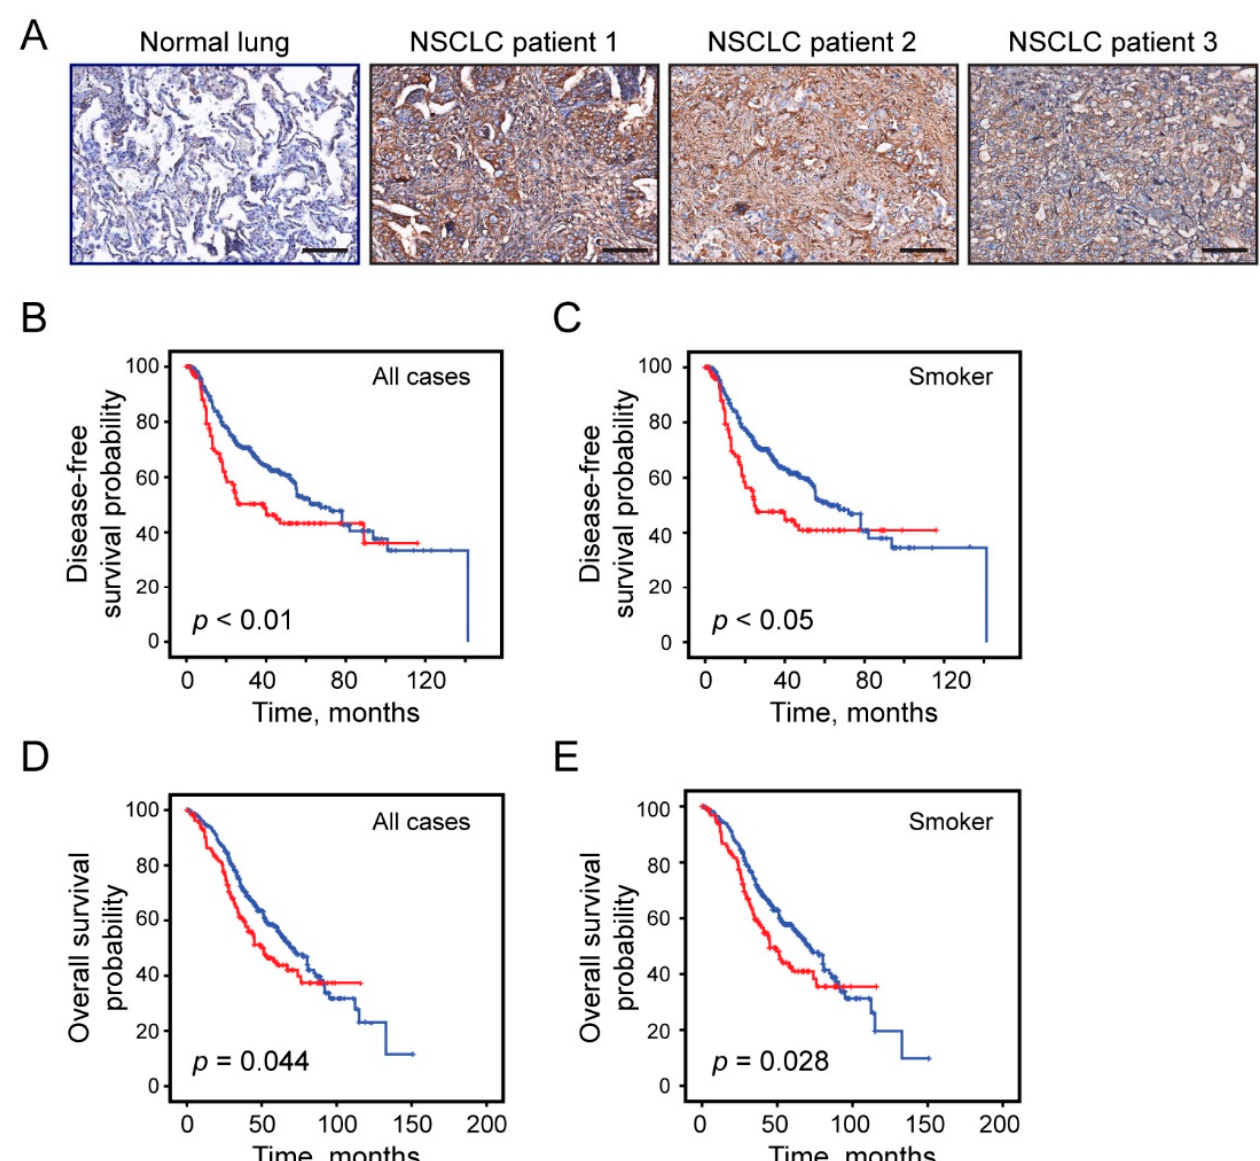
Figure 1. Oncofetal CS expression in NSCLC and survival analyses: ( A ) representative images of oncofetal CS expression in normal human lung and NSCLC tissue samples. The scale bar represents 100 µ m. ( B ) Survival estimates of disease-free survival (DFS) in all cases and ( C ) smokers. ( D ) Estimate of overall survival (OS) in all early-stage NSCLC patients and ( E ) smokers. Red color bar: high oncofetal CS expression; blue: low expression. Patients were divided into “high” ( ≥ 100) and “low” (<100) groups based on the expression of oncofetal CS average stroma and tumor H -score.